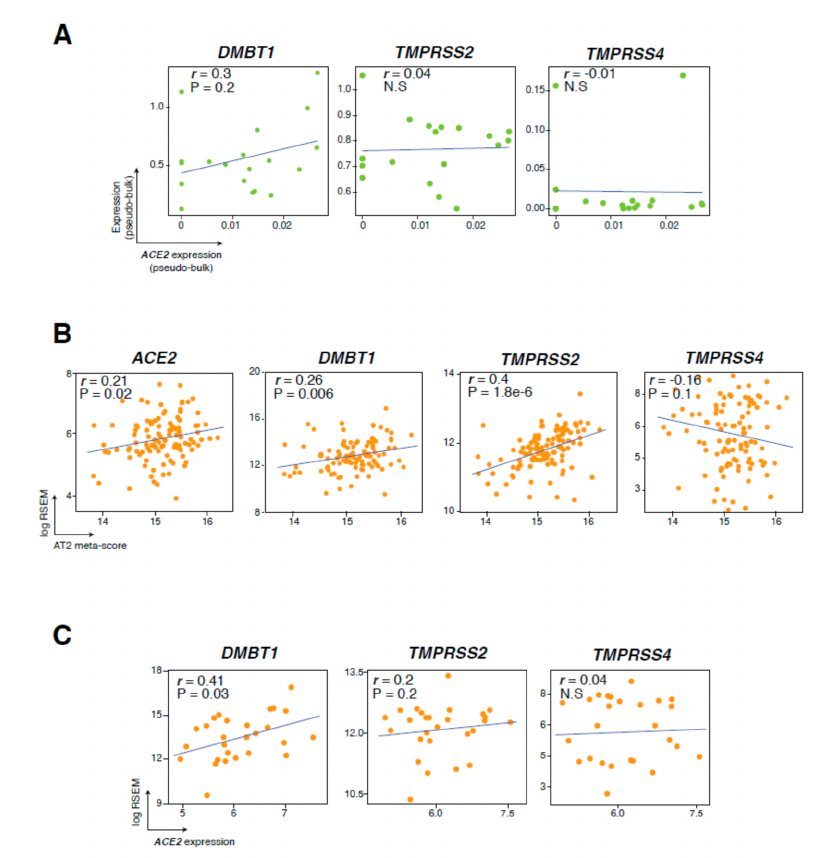
Figure 4. Expression of the viral scavenger DMBT1 correlates with that of ACE2 in lung AT2 cells. ( A ) Correlation between ACE2 and DMBT1, TMPRSS2, and TMPRSS4 expression in pseudobulk data from this study. ( B ) Scatter plots showing significant correlations between estimated AT2 cell fractions and ACE2 , DMBT1, TMPRSS2, and TMPRSS4 in TCGA normal lung samples. ( C ) Significant correlation between ACE2 and DMBT1 in TCGA normal lung samples with high AT2 cell fractions (meta-score > 15.48). Correlations were statistically analyzed using Pearson’s correlation